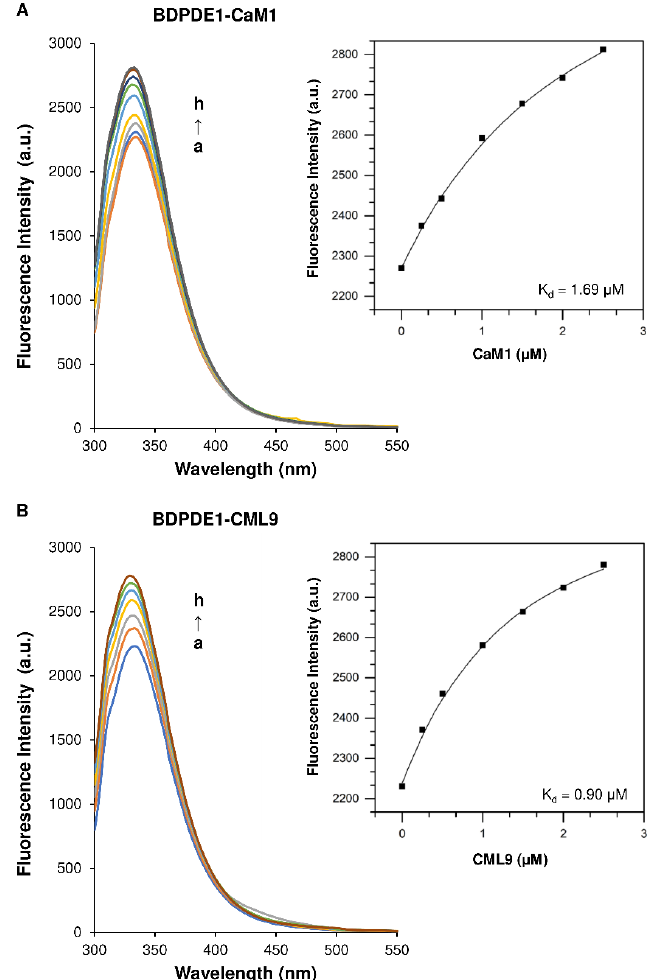
Figure 3. The fluorescence data of BDPDE1 in the presence of ( A ) CaM1 and ( B ) CML9 at 37 °C. (left). Emission spectra of BDPDE1 in the presence of CaM1 and CML9 (right) and the dependence of the fluorescence intensity on the CaM1 and CML9 concentrations. The concentration of BDPDE1 was 0.5- μM. The concentrations of CaM1 and CML9 from “ a ” to “ h ” were 0, 0.25, 0.5, 1.0, 1.5, 2.0 and 2.5 μM, respectively.